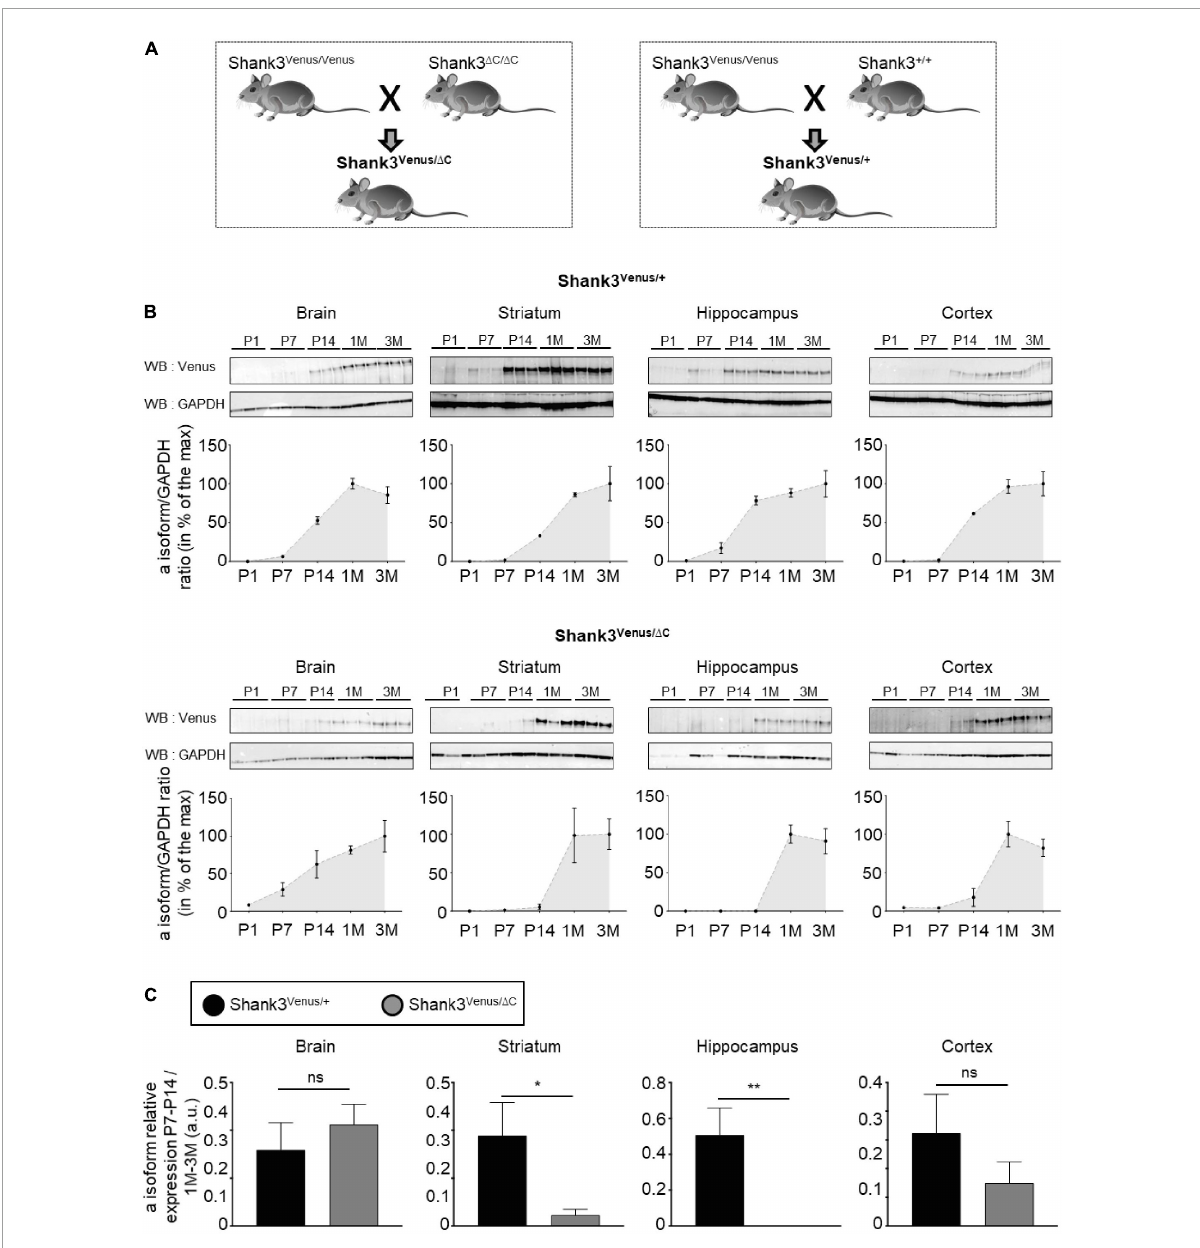
FIGURE5 Expression of Shank3a isoform in ASD. (A) Mouse lines crossing scheme. (B) Total lysates extracted from full brain, striatum, hippocampus, and cortex of Shank3 Venus / + (top) or Shank3 Venus /(cid:49) C (bottom) mice at different developmental stages, from Postnatal day 1 (P1) to 3 months-old (3M), immunoblotted for Venus and GAPDH. All replicates are presented, each from a different mouse. Data are expressed as a percentage of the maximum Shank3a/GAPDH ratio average. (C) Shank3a/GAPDH ratio in juvenile (P7 and P14) mice, expressed as a percentage of expression in adult mice (1 and 3 months) quantified in different brain regions from Shank3 Venus / + (black) and Shank3 Venus /(cid:49) C (gray) mice. n = 6 samples from 6 different mice for each structure at each time point, excepted for Shank3 Venus /(cid:49) C mice at P7–14 where n = 5. Data are mean ± SEM. ns: not significant; p -value: * < 0.05; p -value: ** < 0.01 Mann–Whitney test.